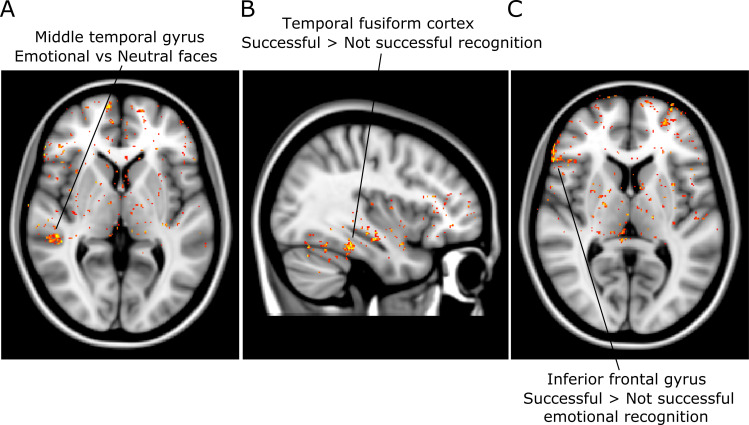
Encoding-related brain activation for recognition contrasts.Note: (A) Right middle temporal gyrus activation during encoding (Emotional >Neutral, threshold at p<0.05, uncorrected). (B) Right temporal fusiform cortex activation during encoding (Successful >Not successful recognition, threshold at p<0.05, uncorrected). (C) Right inferior frontal gyrus activation during encoding (Emotional successful recognition >neutral successful recognition, threshold at p<0.05, uncorrected). Significant activation following cluster correction was detected for the (Emotional >Neutral) contrast in the right middle temporal gyrus (peak z-value = 3.77, MNI coordinates [68,-35,-5], cluster volume = 157 mm). For the (Successful recognition >Not successful recognition) contrast significant activation was found in the right temporal fusiform cortex (peak z-value = 4.13, MNI coordinates [39,-35,-21], cluster volume = 101 mm). For the interaction (Emotional successful recognition >neutral successful recognition) a significant cluster was detected in the right inferior frontal gyrus (peak z-value = 4.08, MNI coordinates [Ekman, 1992; Lane et al., 2009; Wagatsuma et al., 2018], cluster volume = 191 mm). No clusters were visible in the amygdala, hippocampus, entorhinal cortex or locus coeruleus for the above contrasts.